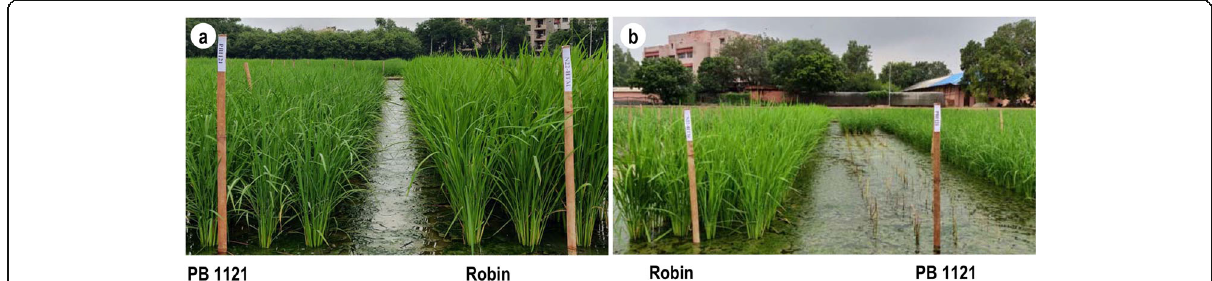
Fig. 2 Phenotypic evaluation of donor parent, “ Robin ” and recurrent parent, “ PB 1121 ” for Imazethapyr herbicide tolerance @ concentration of 2.5 ml/liter, a Unsprayed, b Sprayed